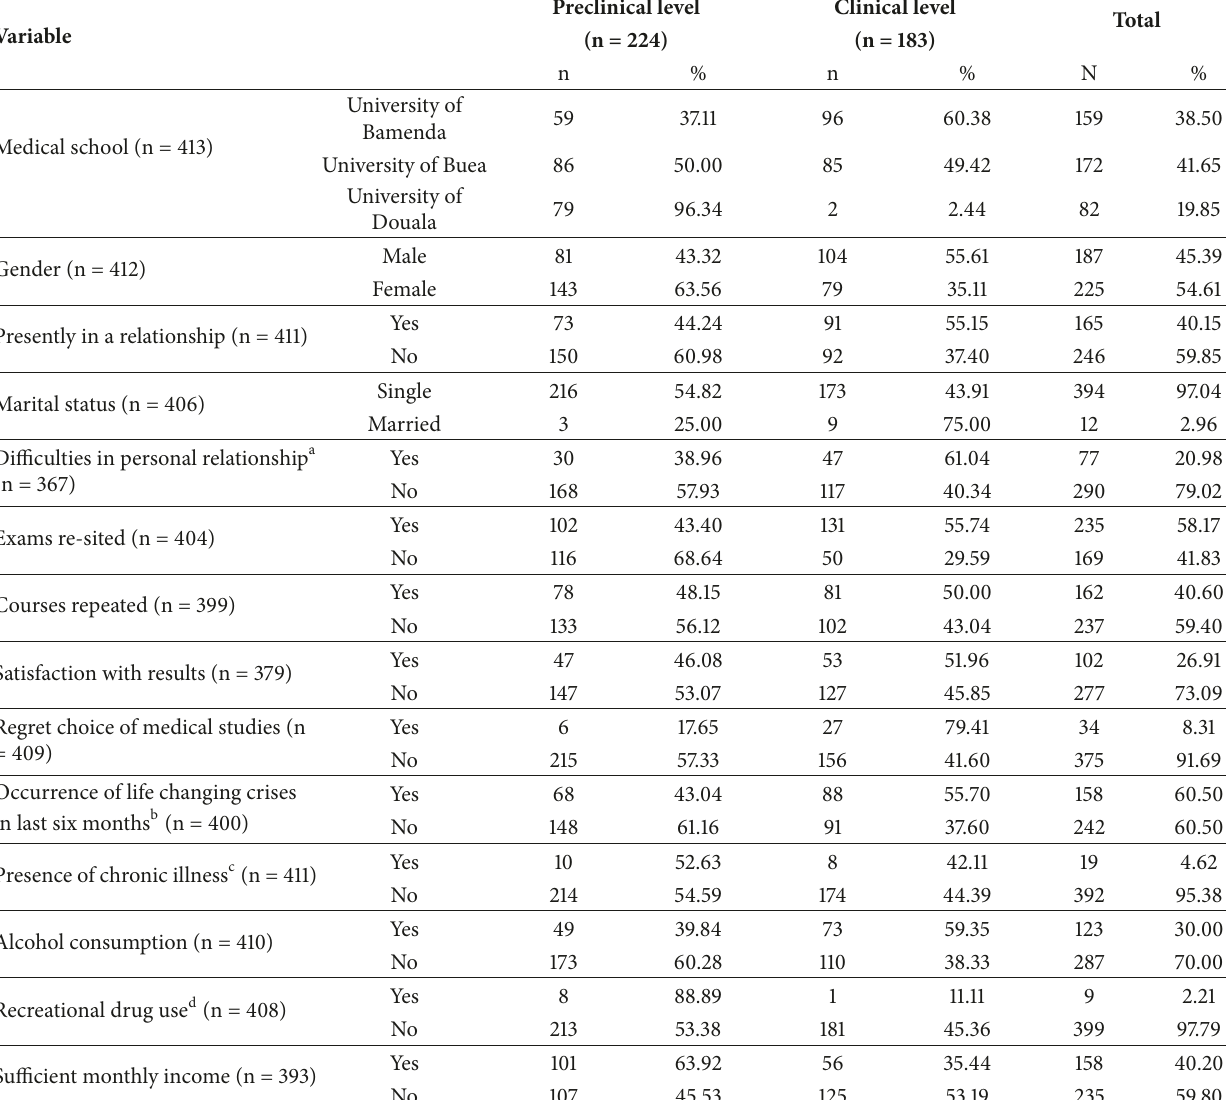
Table 1: Categorical variables showing the sociodemographic characteristics of 413 medical students in Cameroon assessed for burnout syndrome from January to March 2018.